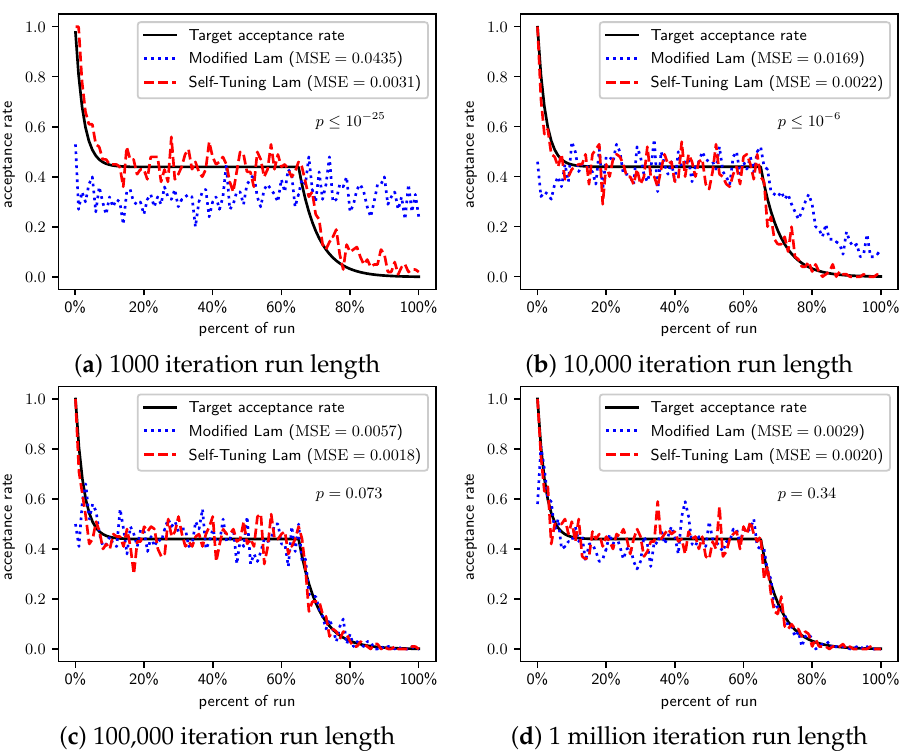
Figure 13. Minimize f 2,10 ( x ) : Self-Tuning Lam, Modified Lam, and target acceptance rates for